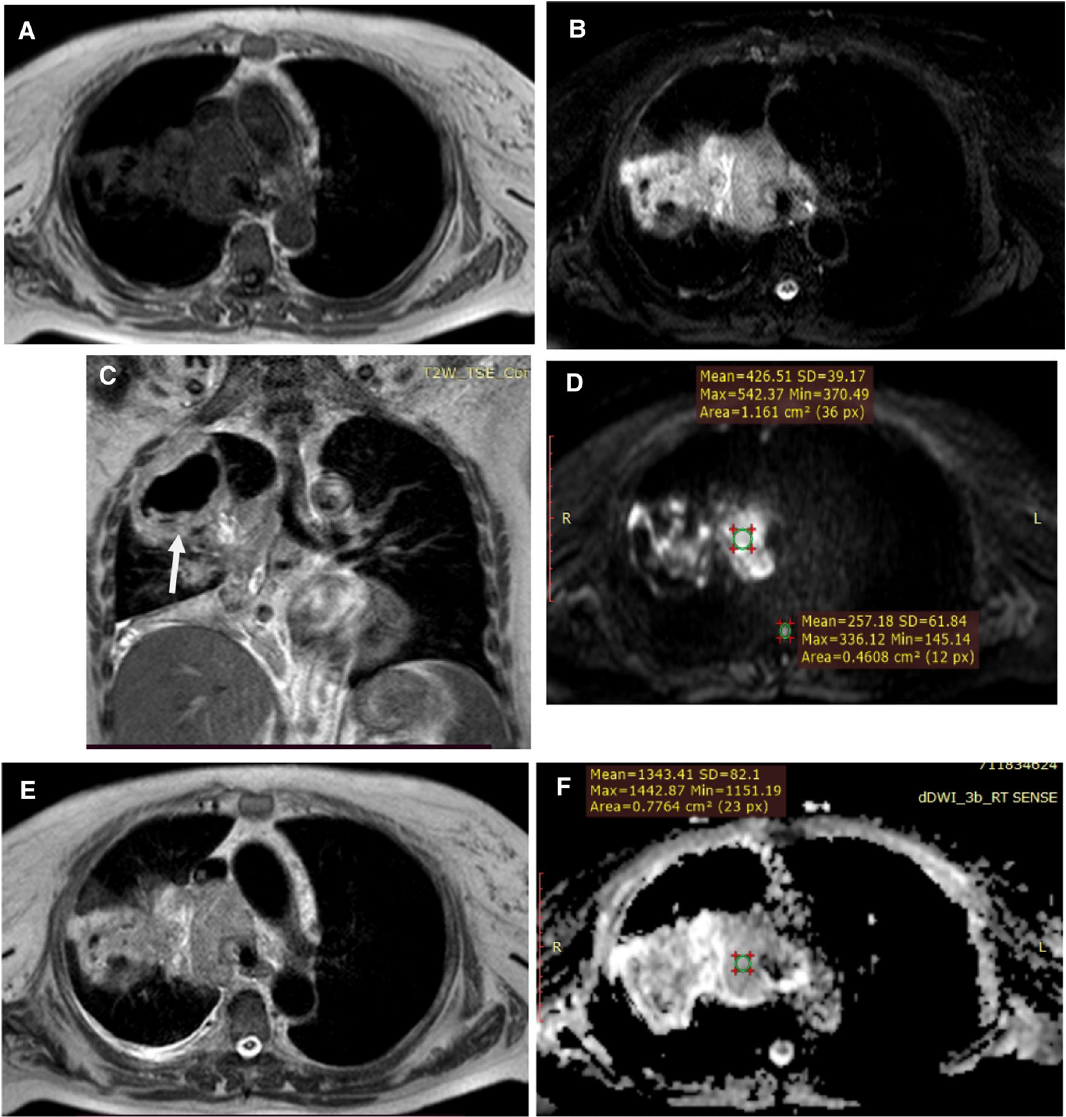
Fig. 2 Female patient 74‑years‑old presenting with cough, dyspnea and hemoptysis with massive weight loss. A‑D: Axial T1 ( A ), axial T2 ( B ), axial STIR ( C ), coronalT2 ( D ) weighted MR images show large right upper lobar soft tissue mass lesion measuring 7.2 axial and craniocaudal dimensions respectively. It elicits isointense signal and hyperintense signal relative to the surrounding muscles on T1 and T2 respectively. It shows right hilar and mediastinal extensions encroaching on the lumen of the trachea and right main bronchus causing partial collapse of the right upper and middle lobes. It is seen encasing and attenuating the SVC. DWI ( E ) and ADC map ( F ) images show restricted diffusion with LSR 1.65, ADC mean 1.34 and ADC min 1.15. Histopathology revealed squamous cell lung